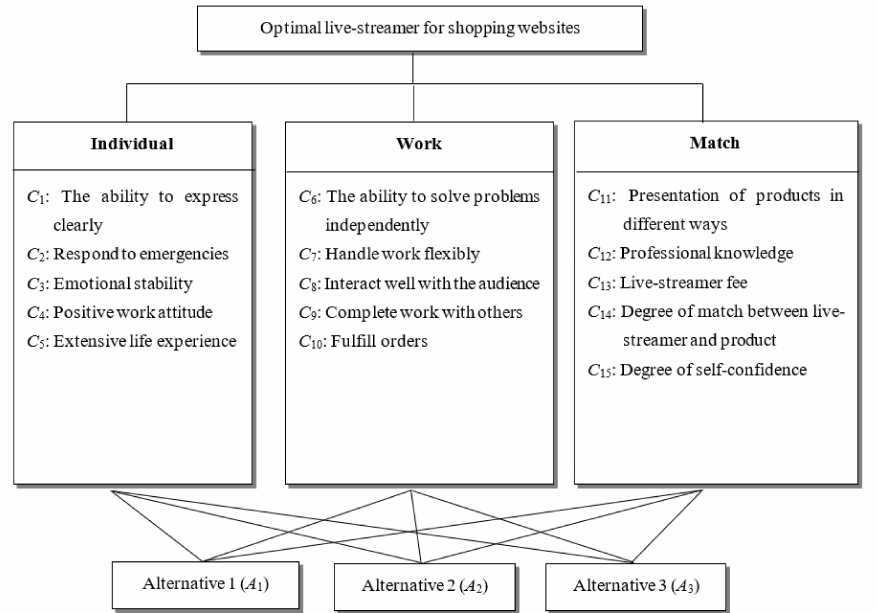
Figure 1. Hierarchical framework to select the optimal live-streamer for shopping